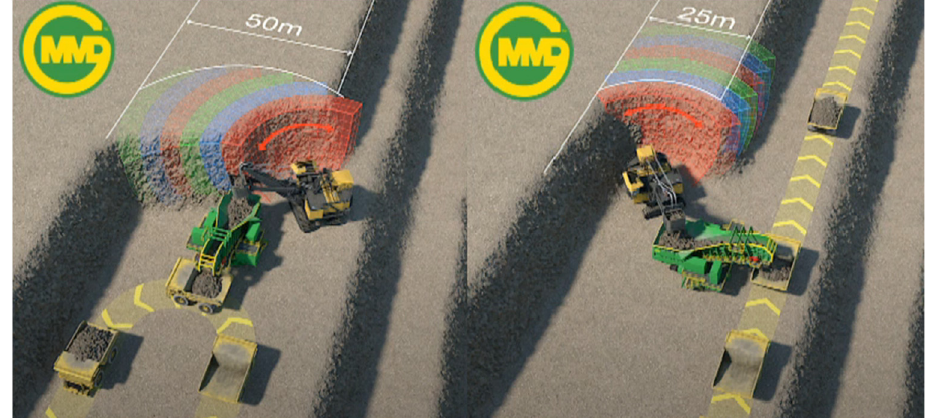
Figure 11. Truck routes with the surge loader [23].